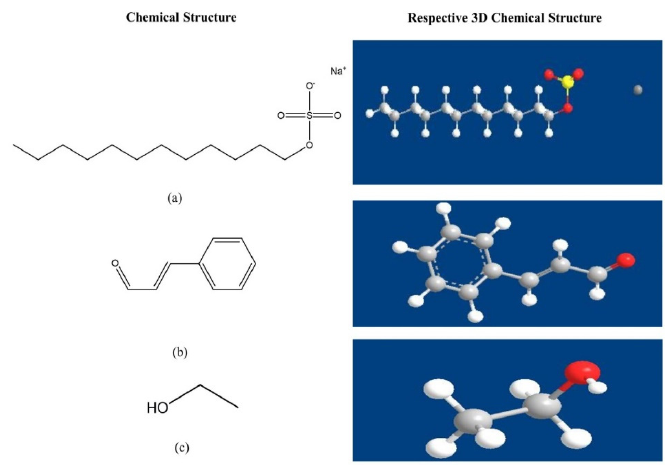
Figure 1. Chemicals and their respective 3D chemical structures of ( a ) sodium dodecyl sulfate, ( b ) cinnamaldehyde and ( c ) ethanol, respectively .